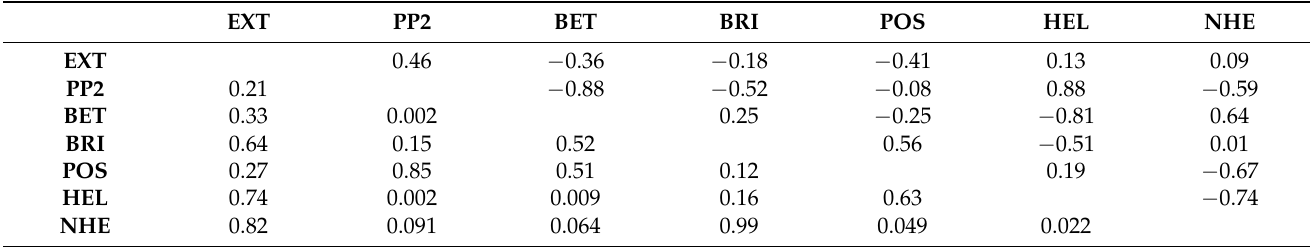
Table 3. Pair-wise comparison of the propensity scales for the ( ϕ , ψ ) clusters identified in the Ramachandran plot. The correlation coefficients R and the p -values are reported on the right and left sides of the diagonal, respectively. The ensemble of the other nine residues (D, N, C, H, W, T, S, Y, and F) is